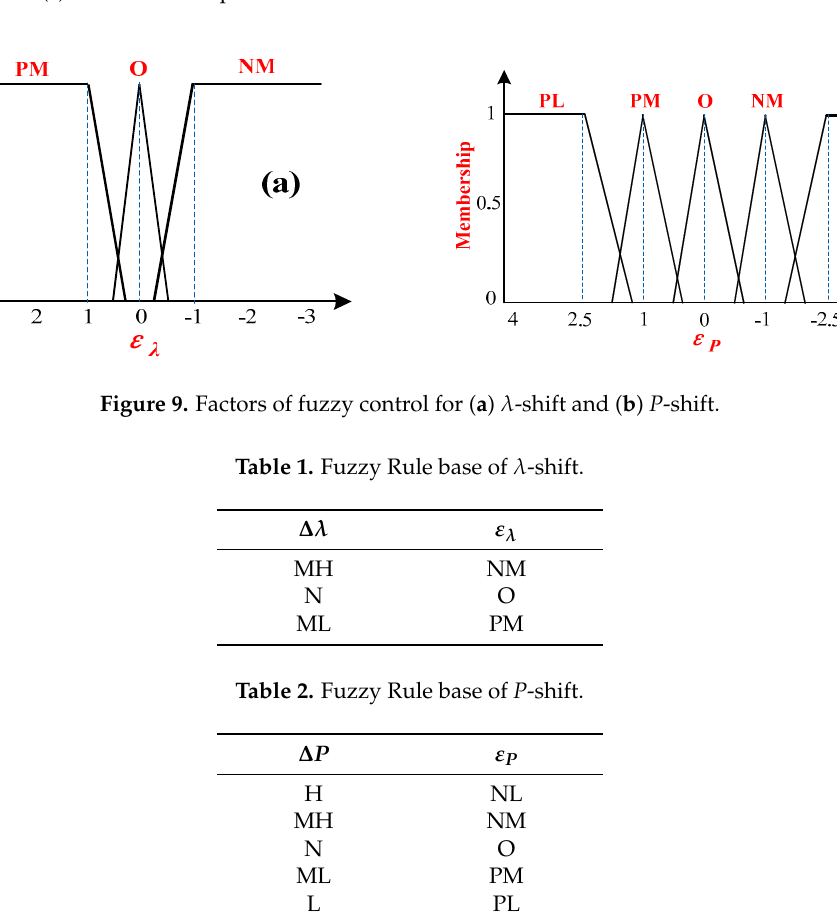
Figure 8. The mean intensity fluctuation of oscillations in the ( a ) long term (600 min), ( b ) short term (50 min) and ( c ) the membership of P -shift.